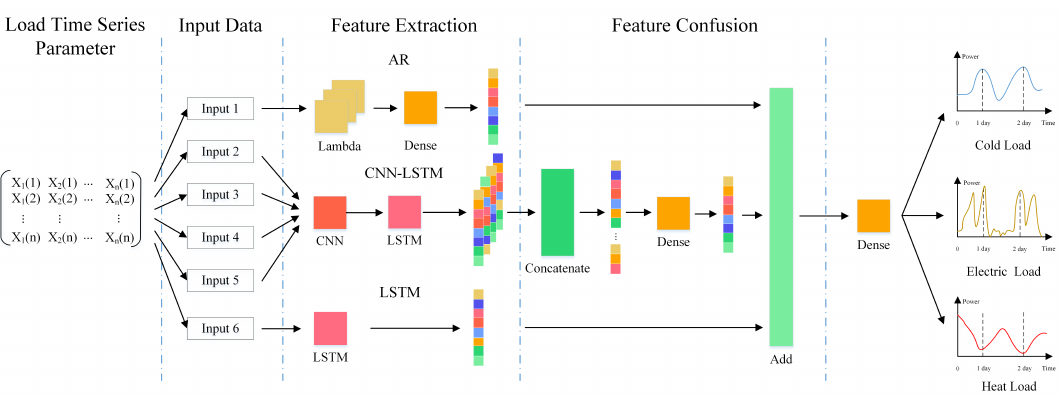
Figure 4. Multi-energy load-forecasting model